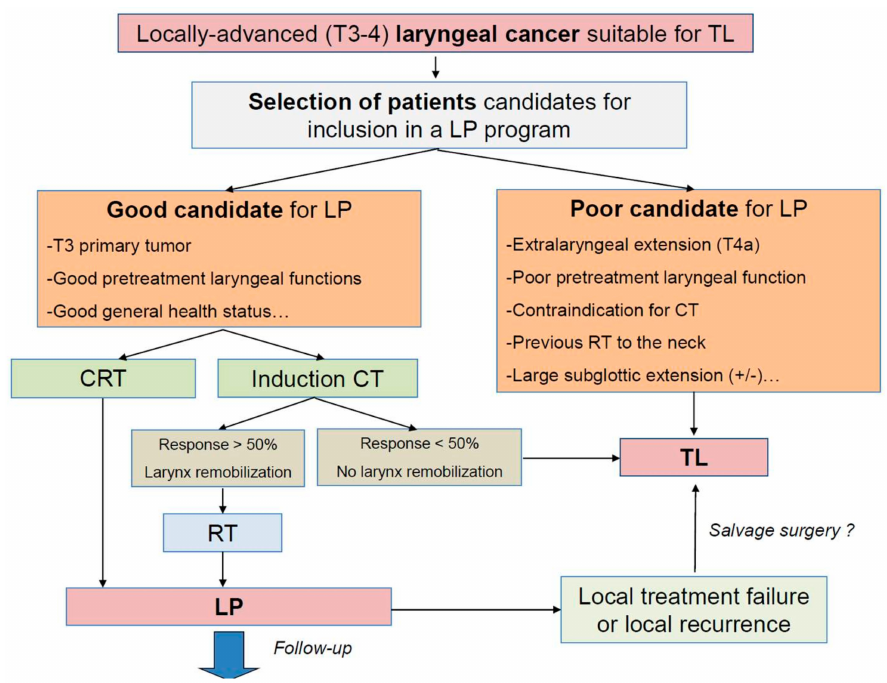
Figure 1. Total laryngectomy and larynx preservation strategies in patients with locally advanced laryngeal (T3–4) cancer. TL: total laryngectomy; LP: larynx preservation; RT: radiotherapy; CT: chemotherapy; CRT: concurrent